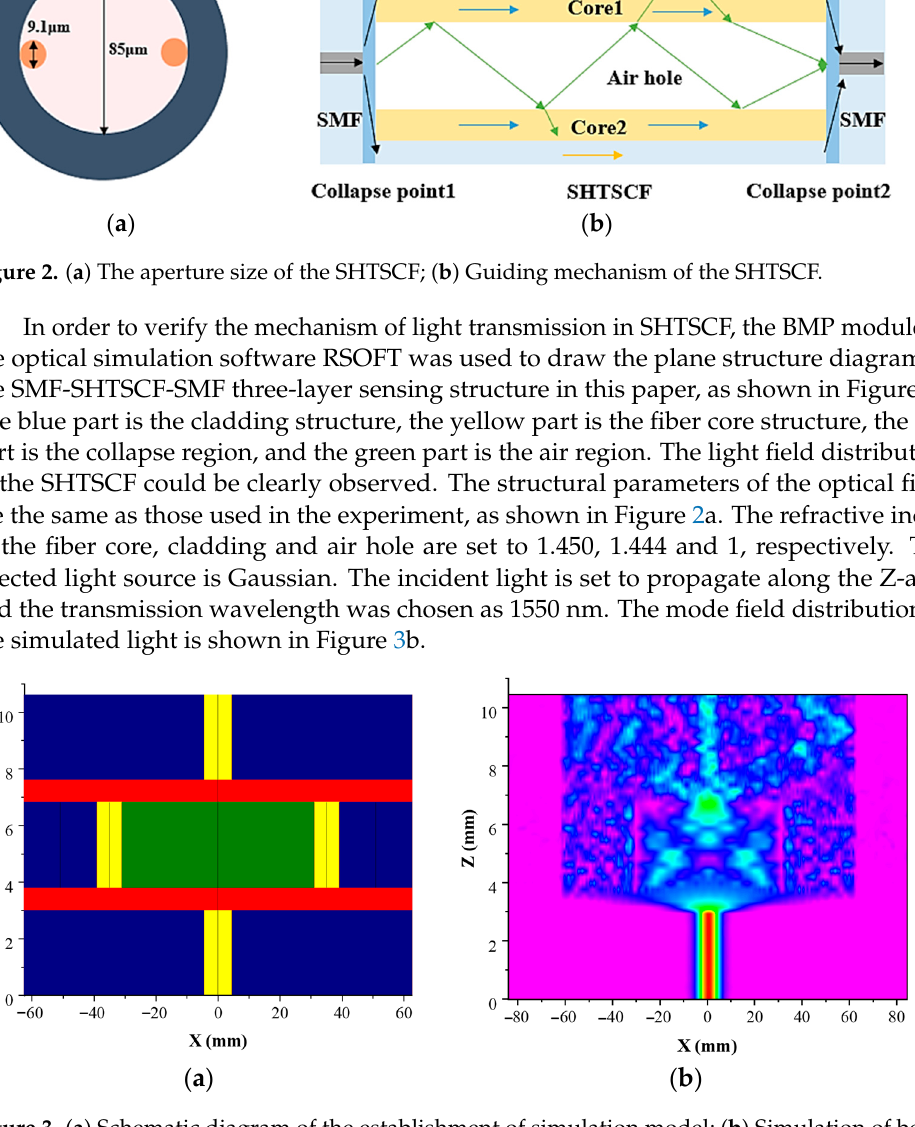
Figure 3. ( a ) Schematic diagram of the establishment of simulation model; ( b ) Simulation of beam propagation at the wavelength of 1550 nm.